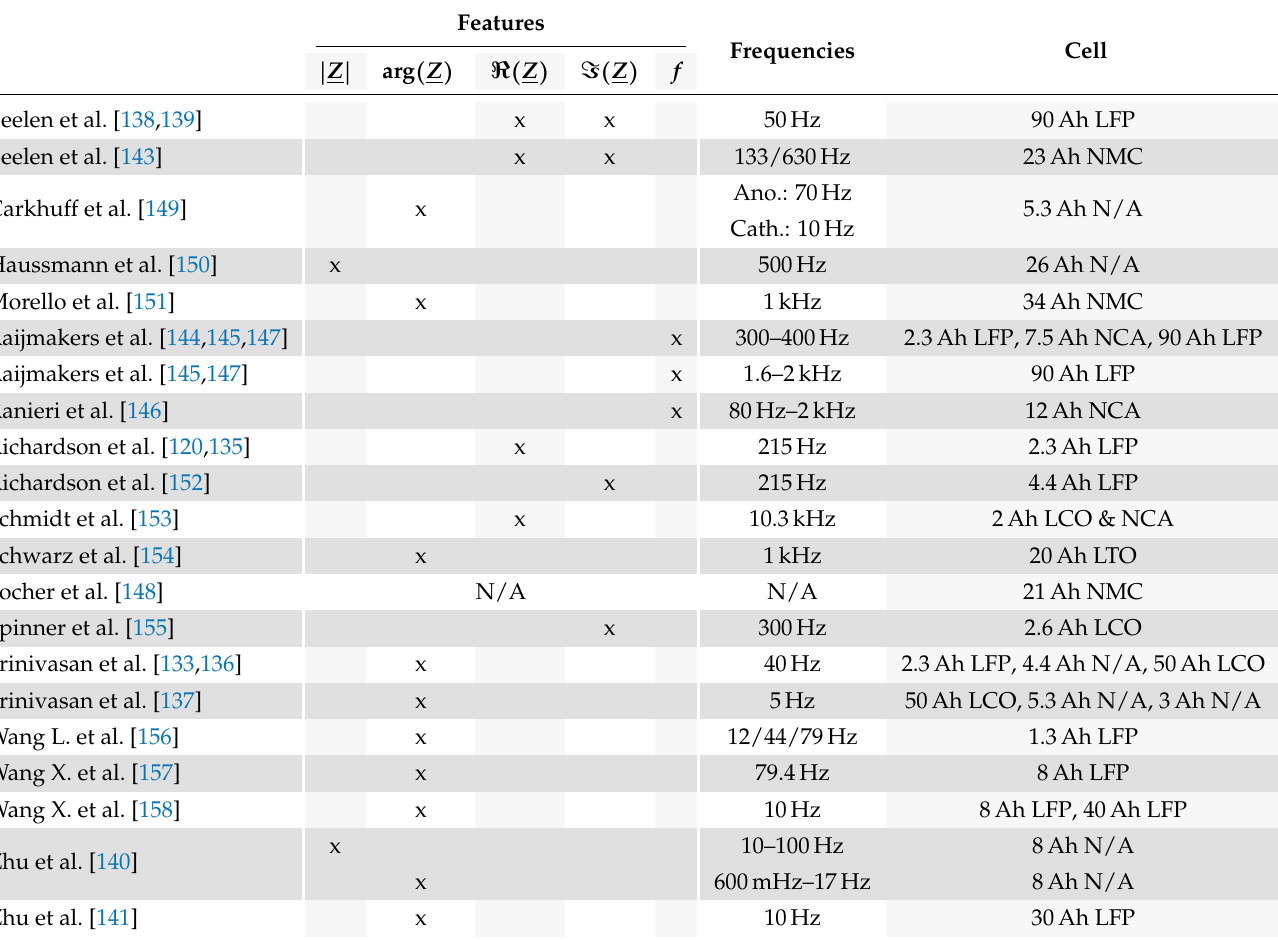
Table 3. EIS-based approaches for the identification of the internal temperature in alphabetical order. Abbreviations: Lithium Titanate Oxide